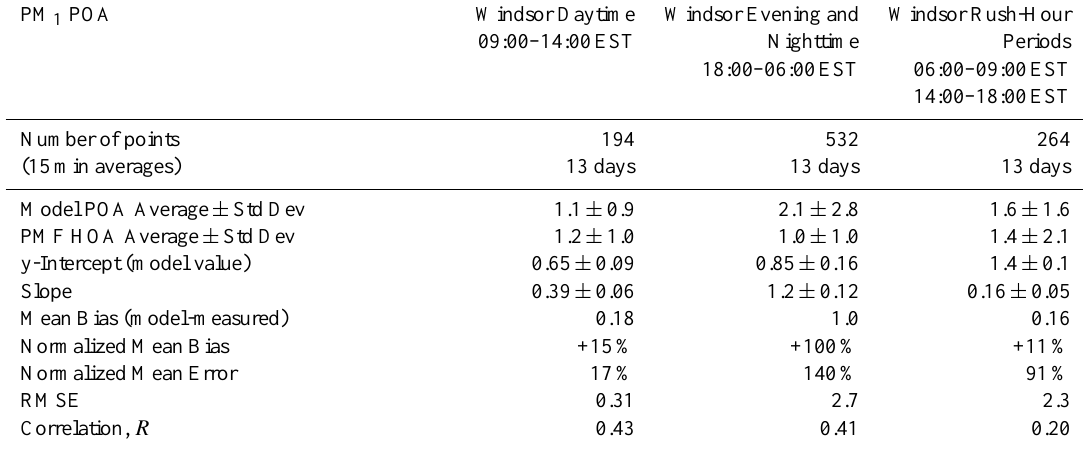
Table 4. AURAMS PM 1 POA model performance statistics for the 2.5-km grid for the urban Windsor site (concentrations in µgm − 3 )